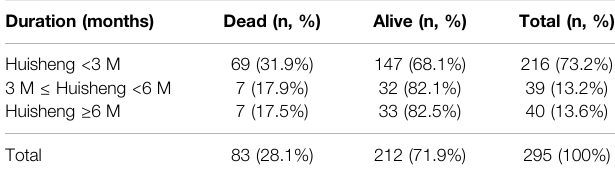
TABLE 6 | Trend of the 2-year survival rate of patients treated with HSOL for different durations. Duration (months) Dead (n, %) Alive (n, %) Total (n, %) Huisheng < 3 M 69